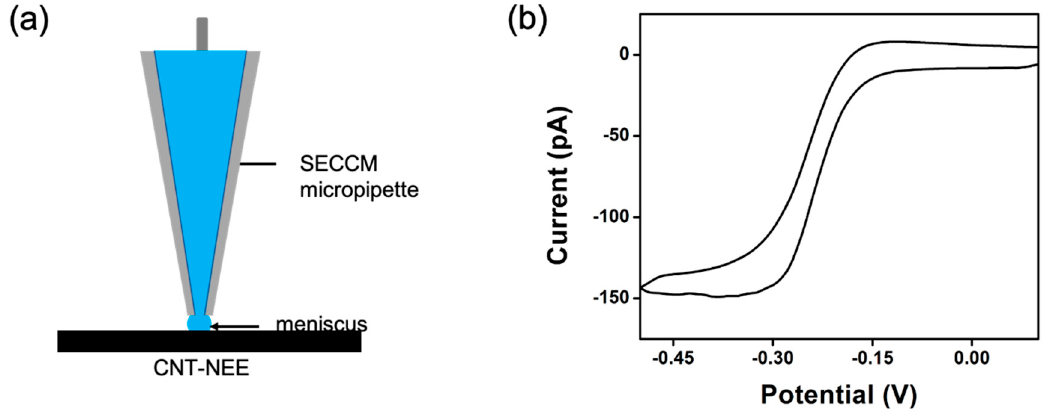
Figure 7. SECCM characterization of the CNT-NEE. ( a ) Illustration of the SECCM contact area, where the CNT-NEE is the working electrode and an Ag/AgCl wire inserted in the micropipette is the QRCE. ( b ) Sigmoidal voltammogram collected using SECCM.